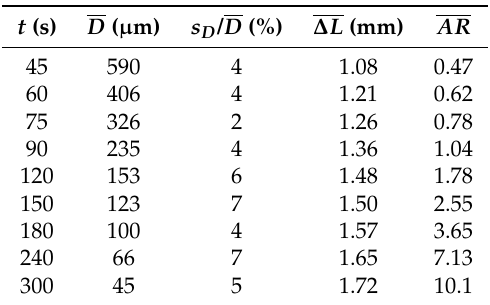
Table 1. Mean geometrical parameters for sets of nozzles manufactured at the same position ( r = 3.5 mm, z = 15 mm) from capillaries type